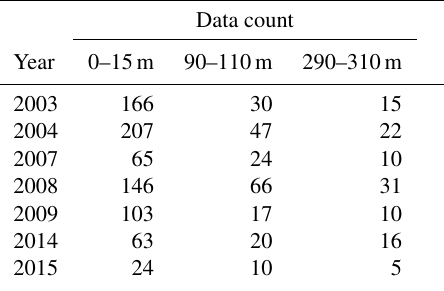
Table A3. Number of data points included in the annual means used in the time of emergence